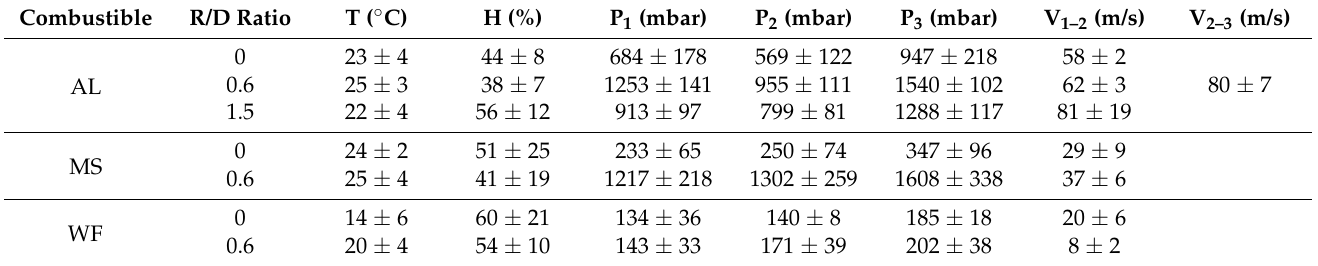
Table 4. Summary of pressures and velocities obtained during the tests and environmental